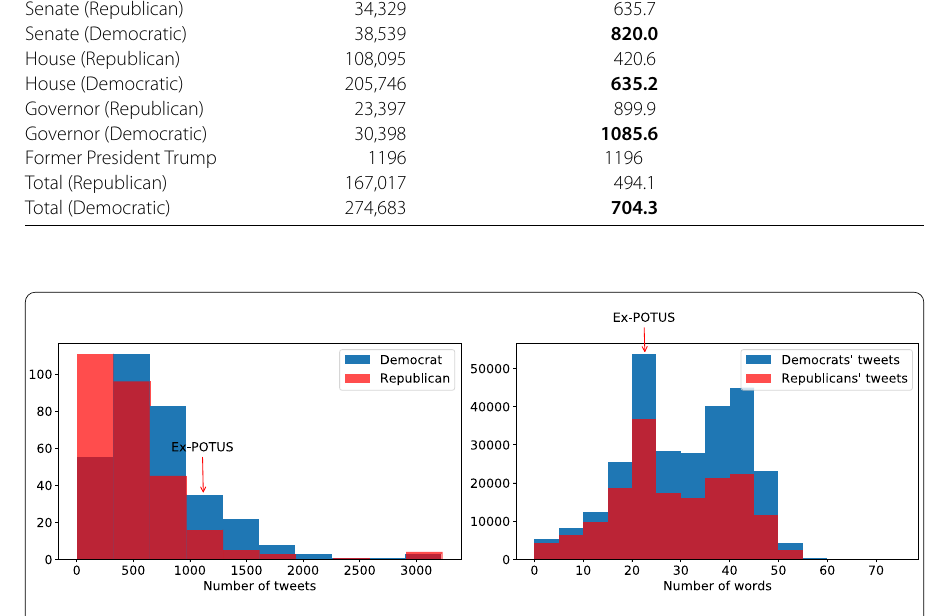
Figure 1 The distribution of the amounts of tweets that politicians post (left) and the length distribution of tweets